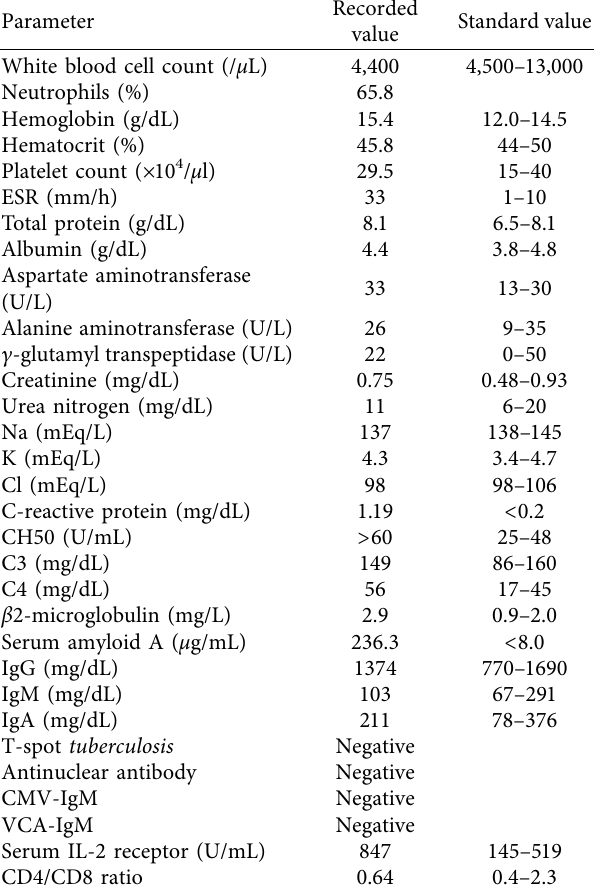
Table 1: Laboratory data on